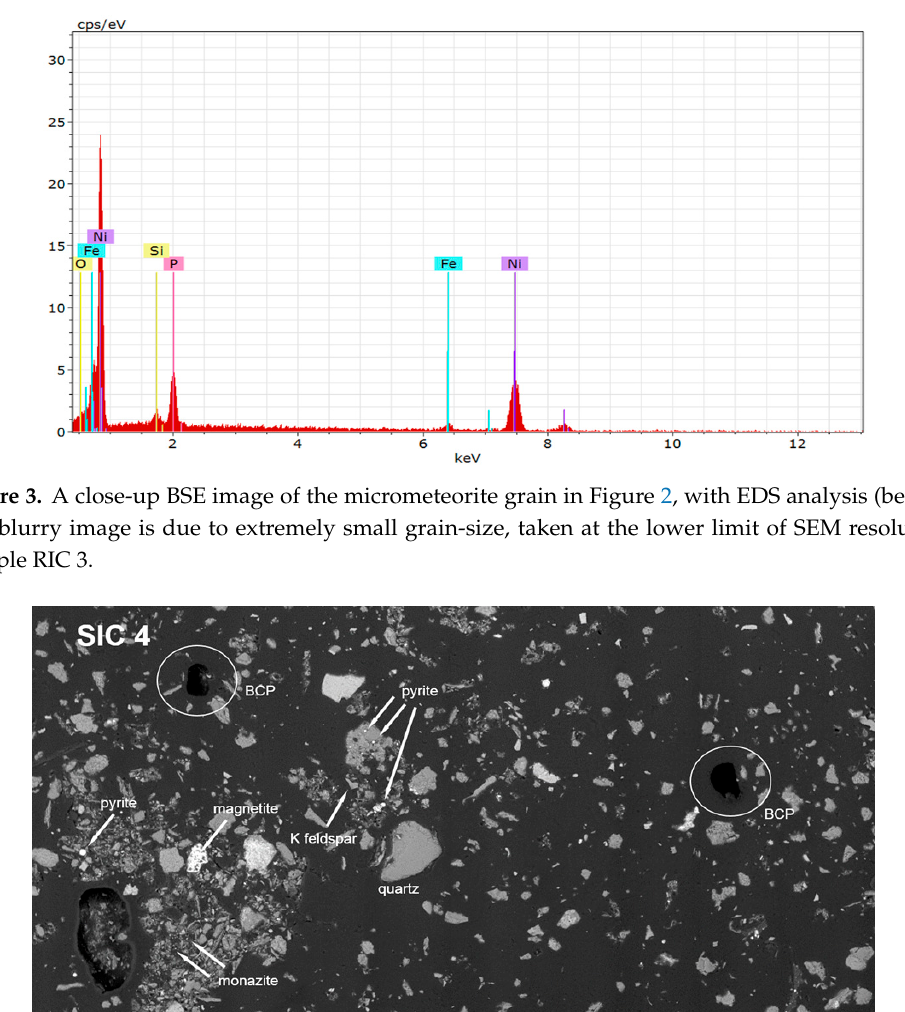
Figure 5. Framboidal pyrite (above) with EDS analysis (below). Microcrystallites are close to the limit of SEM resolution. The star indicates a peak of the C which is coming from the carbon coating of the sample. Sample RIC 3.